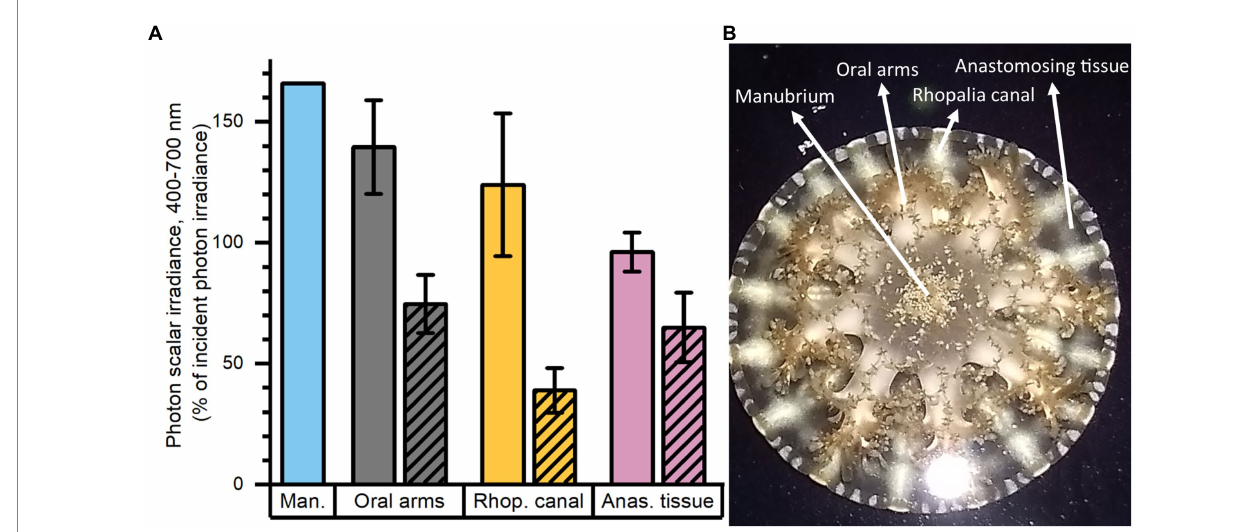
FIGURE 1 Normalized photon scalar irradiance (PAR, 400–700 nm) measured at (A) the manubrium center (Man.), oral arms, rhopalia canals (Rhop. canal) and anastomosing tissue (Anas. tissue) on a single adult medusa of Cassiopea . Bright colors indicate values measured above, and shaded colors the values below the medusa. (B) Overview of the specimen with exemplary positions for measurements (white arrows). Light intensities were mapped at the tissue-water interface (above and below the medusa) at respective anatomical structures ( n = 7–17) using a submersible spherical quantum sensor (see Methods), and normalized against the incident photon irradiance intensity measured at the same sensor positions without the medusae above a black surface. Note, only one measurement was performed above the manubrium